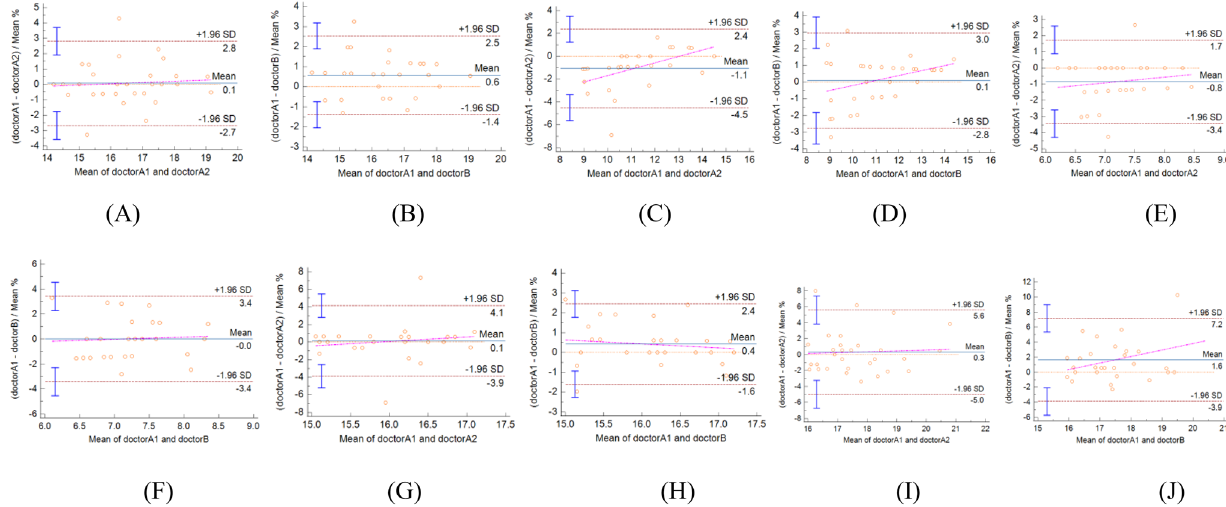
Figure 1. Bland–Altman analyses. Bland–Altman analysis of LVGLS showed that there was a high consistency in intraobserver ( A ). Bland–Altman analysis of LVGLS showed that there was a high consistency in interobservers ( B ). Bland–Altman analysis of AP4MV1 showed that there was a high consistency in intraobserver ( C ). Bland–Altman analysis of AP4MV1 showed that there was a high consistency in interobservers ( D ). Bland–Altman analysis of s’ showed that there was a high consistency in intraobserver ( E ). Bland–Altman analysis of s’ showed that there was a high consistency in interobservers ( F ). Bland–Altman analysis of MAPSE-mean showed that there was a high consistency in intraobserver ( G ). Bland–Altman analysis of MAPSE-mean showed that there was a high consistency in interobservers ( H ). Bland–Altman analysis of 2D-GLS showed that there was a high consistency in intraobserver ( I ). Bland–Altman analysis of 2D-GLS showed that there was a high consistency in interobservers ( J ).